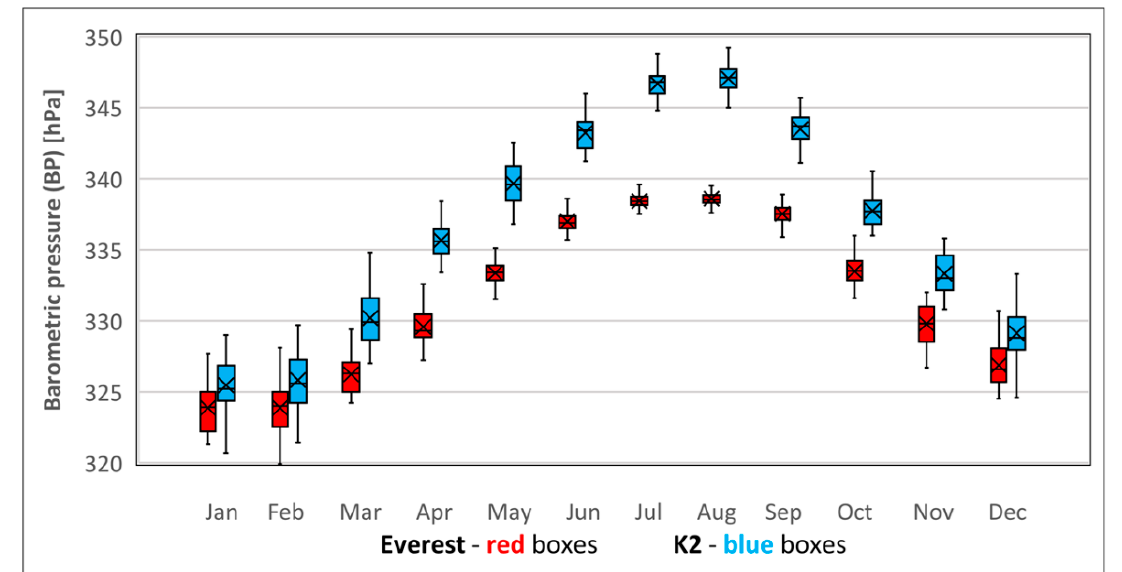
Figure 1. Annual cycle of barometric pressure (BP) at the summits of Everest (red boxes) and K2 (blue boxes). Sample size—41 monthly means (1979–2019). Bars extend to the maximum and minimum BP, boxes span the 25th–75th percentiles, crosses inside the boxes mark the monthly mean, and vertical lines inside the boxes represents the monthly median. BP values for all the corresponding months on the two summits were found to differ significantly ( p < 0.001). Midwinter BP values on both peaks were lower than in the climbing season ( p <